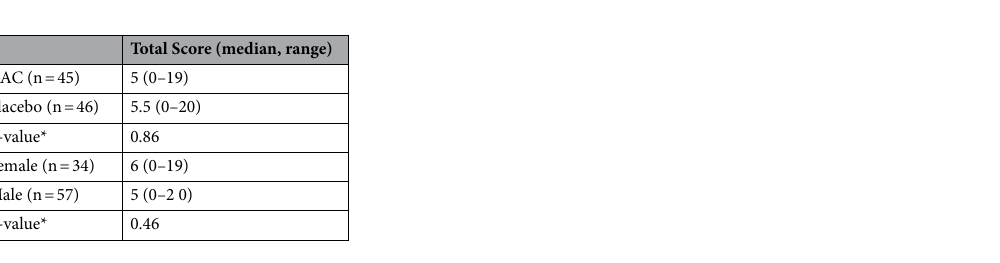
Table 1. No statistically significant difference when comparing the subset of the 5 valid hangover symptoms. *Based on separate Mann Whitney rank sums tests.